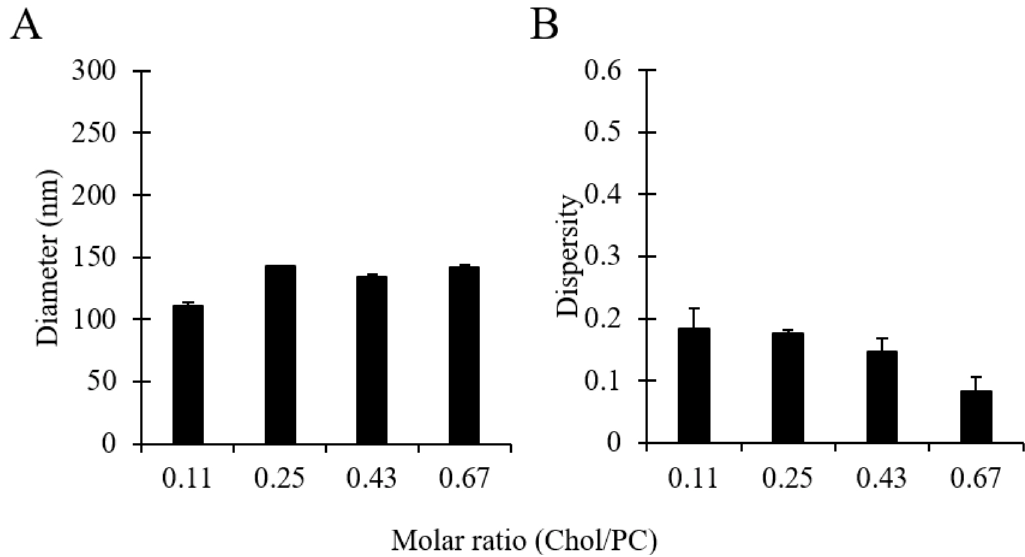
Figure 7. Effects of cholesterol concentration (in the molar range 1:9 to 1:1.5, at a total concentration of 16 mM) on liposome size ( A ) and dispersity ( B ). Data represent the means of three measurements with corresponding standard deviations. Refer to Table 1 (batch code #18 PC to #21 PC) for the corresponding experimental conditions, lipid compositions, and numerical data of mean values and standard deviations.